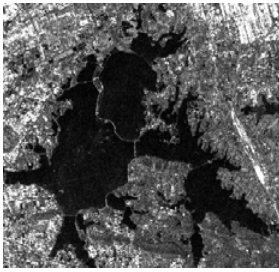
Figure 5. The SAR image